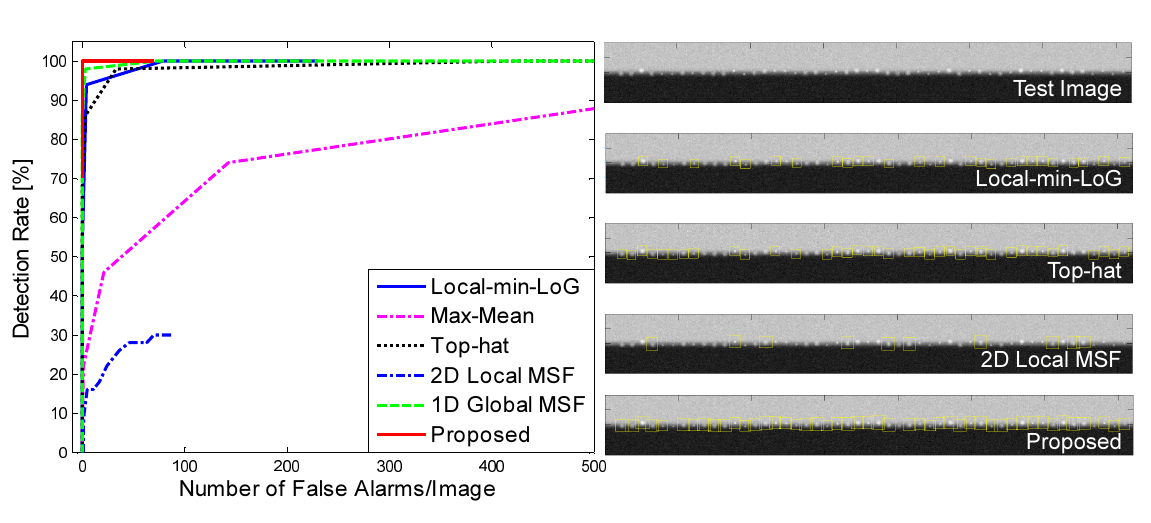
Figure 24. ROC curves and related detection examples. ( a ) ROC curves of three different spatial filters; ( b ) detection examples with thresholds of zero false alarms.